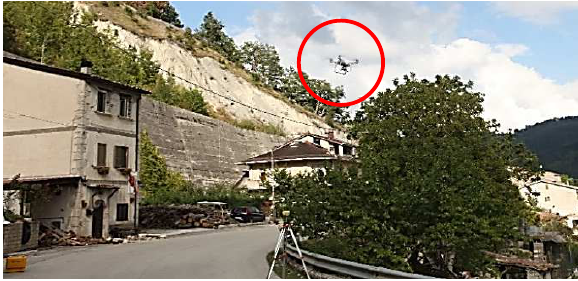
Figure 6. Phantom 4 DJI piloted drone (in red circle) during